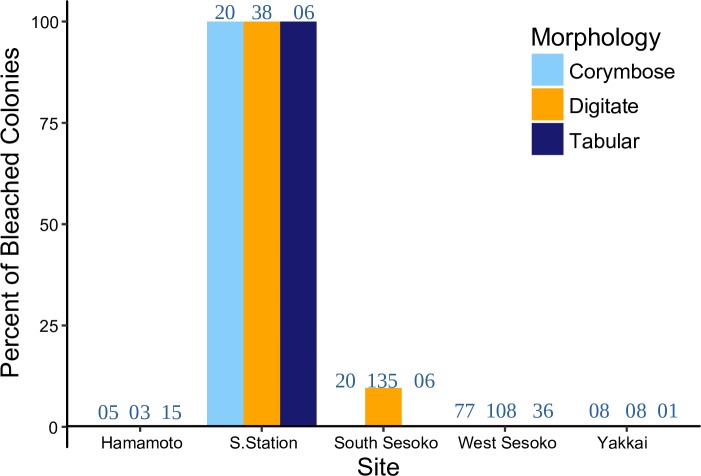
Spatial variation in bleaching prevalence (percent of bleached colonies) of the different Acropora morphologies around Sesoko Island in October 2016.Sample numbers per group are in blue text.